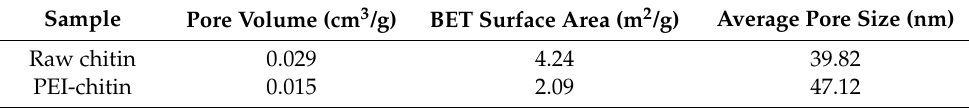
Figure 2. N 2 adsorption–desorption isotherms and pore size distributions (insert figure) of raw chitin and PEI-chitin. Table 2. Pore volume, specific surface area, and average pore size of raw chitin and